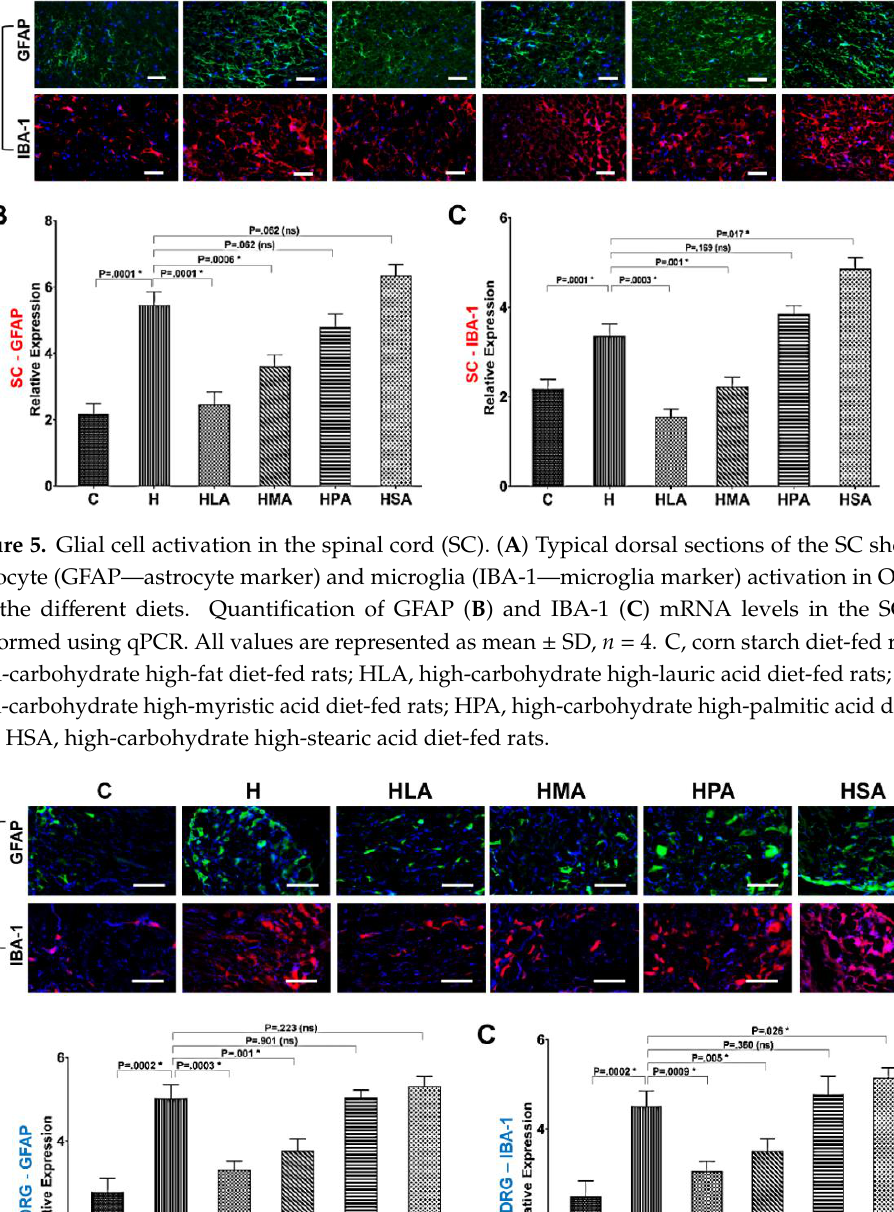
Figure 4. Histological evaluation of the knee joints. Pictures were obtained under 4× and 20× magnifications representing the medial tibial plateau. (A) Sections of articular cartilage stained with Safranin O/Fast Green shows the extent of proteoglycan loss among the different diet groups in both sham and osteoarthritic (OA) rats. (B) The severity of articular cartilage degradation was graded using Mankin scoring system in both sham and OA rats. All values are represented as mean ± SD, n = 6. C, corn starch diet-fed rats; H, high-carbohydrate high-fat diet-fed rats; HLA, high-carbohydrate high- lauric acid diet-fed rats; HMA, high-carbohydrate high-myristic acid diet-fed rats; HPA, high- carbohydrate high-palmitic acid diet-fed rats; HSA, high-carbohydrate high-stearic acid diet-fed rats.